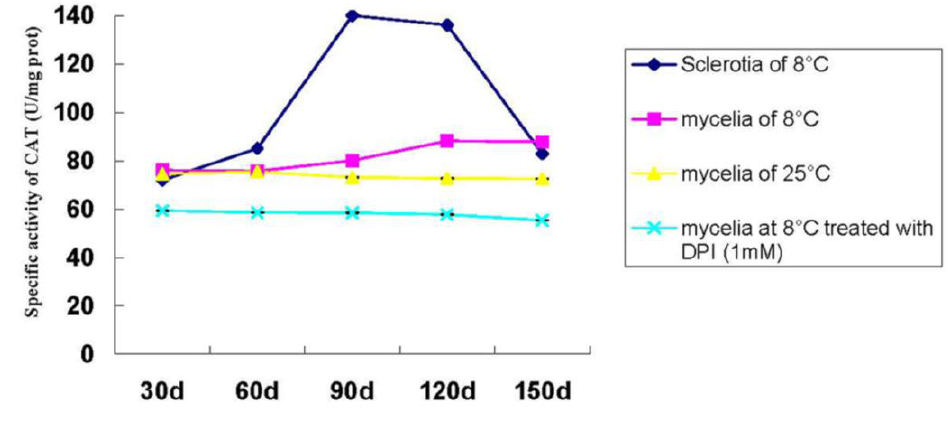
(Figure 7). After being treated with the antioxidant DPI (1 mmol L −1 ), the CAT activity performed in a similar manner to the SOD activity during the P. umbellatus sclerotial formation (Figure 7). Figure 7. CAT activity during P. umbellatus sclerotial formation. Mean values ± SD or representatives of at least three independent experiments are shown ( n =